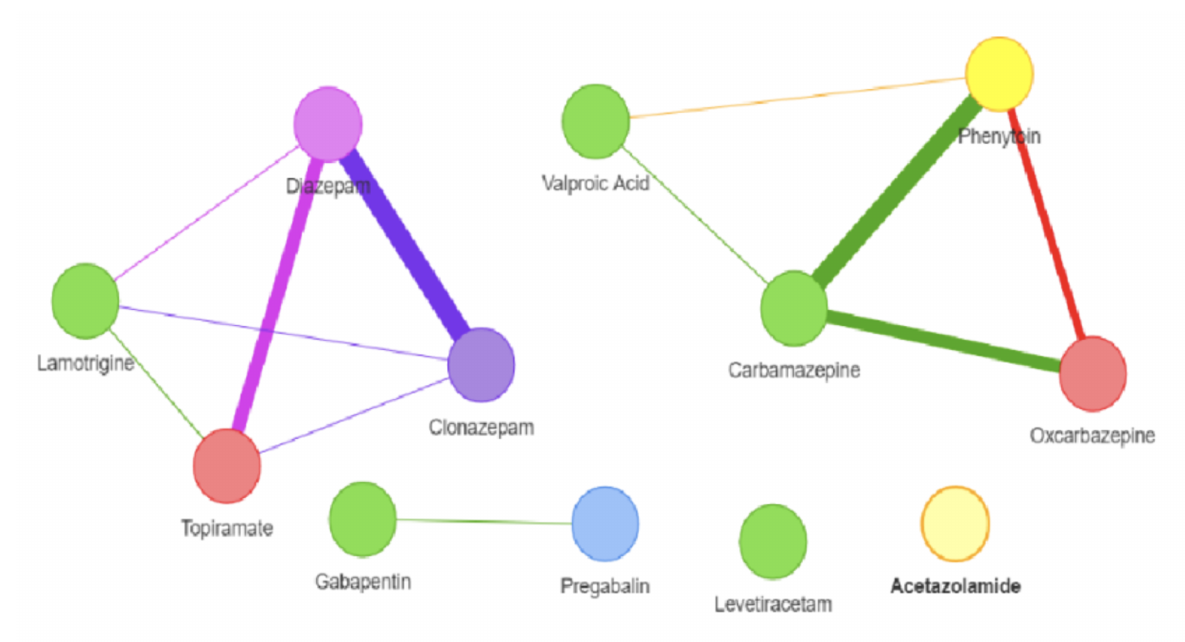
Figure 3. AEDs . Drug-Drug Similarity-based correlations from